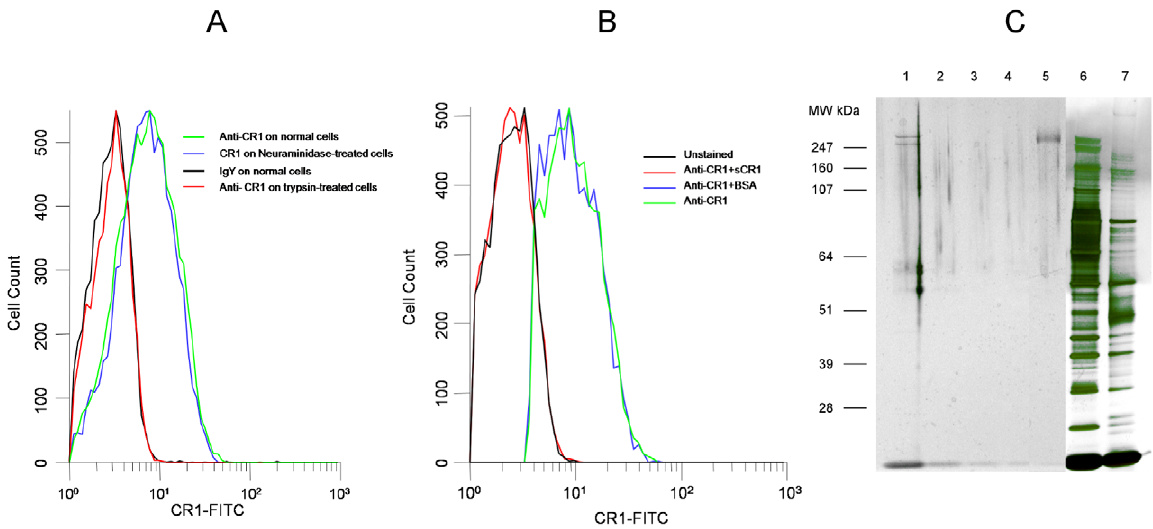
Figure 1. Chicken anti-human CR1 recognizes red cell CR1. (A) Binding of chicken anti-human CR1 Fab is abolished by treatment of erythrocytes with trypsin but not with neuraminidase. (B) Binding of chicken anti-CR1 Fab to human red cells is abolished by incubation with soluble CR1 (sCR1) but not by bovine serum albumin. (C) PAGE of chicken anti-CR1 immunoprecipitates, sCR1 and red cell lysates run on Novex Nupage Bis- tris 4–12% acrylamide gel under reducing conditions and stained with silver. Lane 1: Immunoprecipitate with chicken anti-CR1 from intact red cell lysate. Lane 2: Immunoprecipitate with chicken anti-CR1 from trypsin-treated red cell lysate. Lane 3: Immunoprecipitate with control chicken IgY from intact red cell lysate. Lane 4: Immunoprecipitate with chicken IgY from trypsin-treated red cell lysate. Lane 5: 0.01 m g of purified sCR1. Lane 6: 1 m l of intact red cell lysate used for immunoprecipitation. Lane 7: 1 m l of trypsin-treated red cell lysate used for immunoprecipitation.